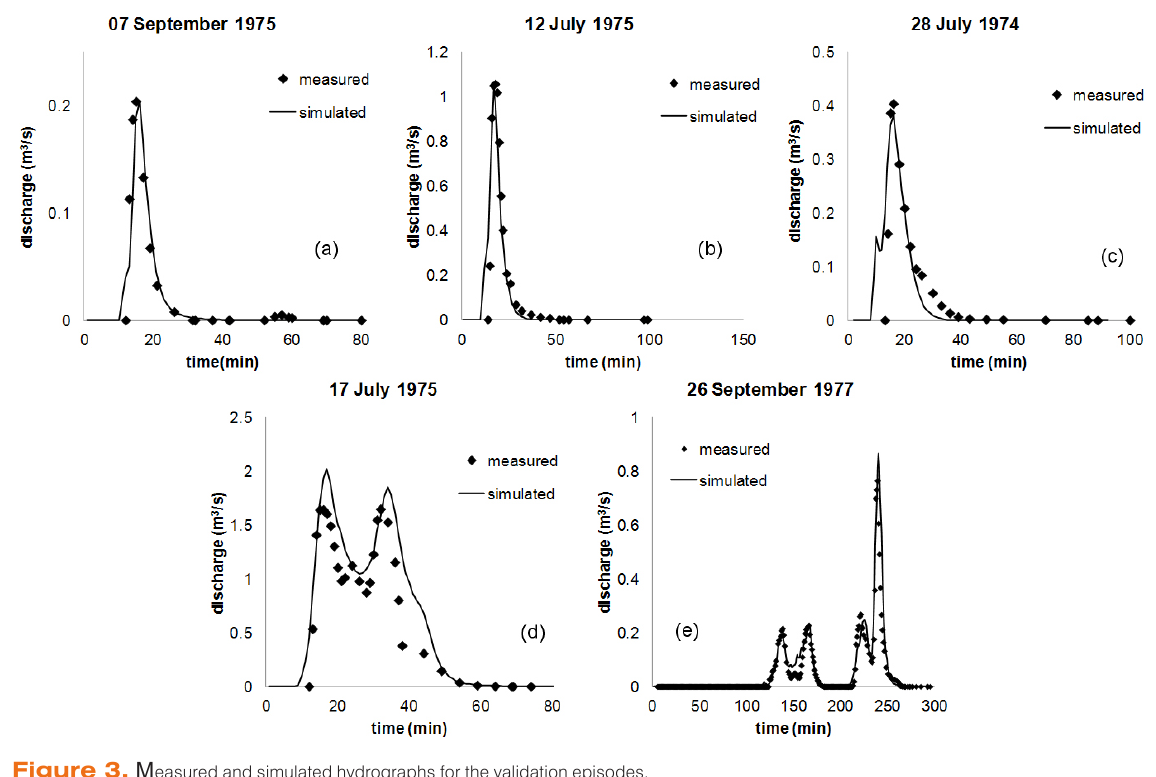
Figure 3. M easured and simulated hydrographs for the validation episodes.